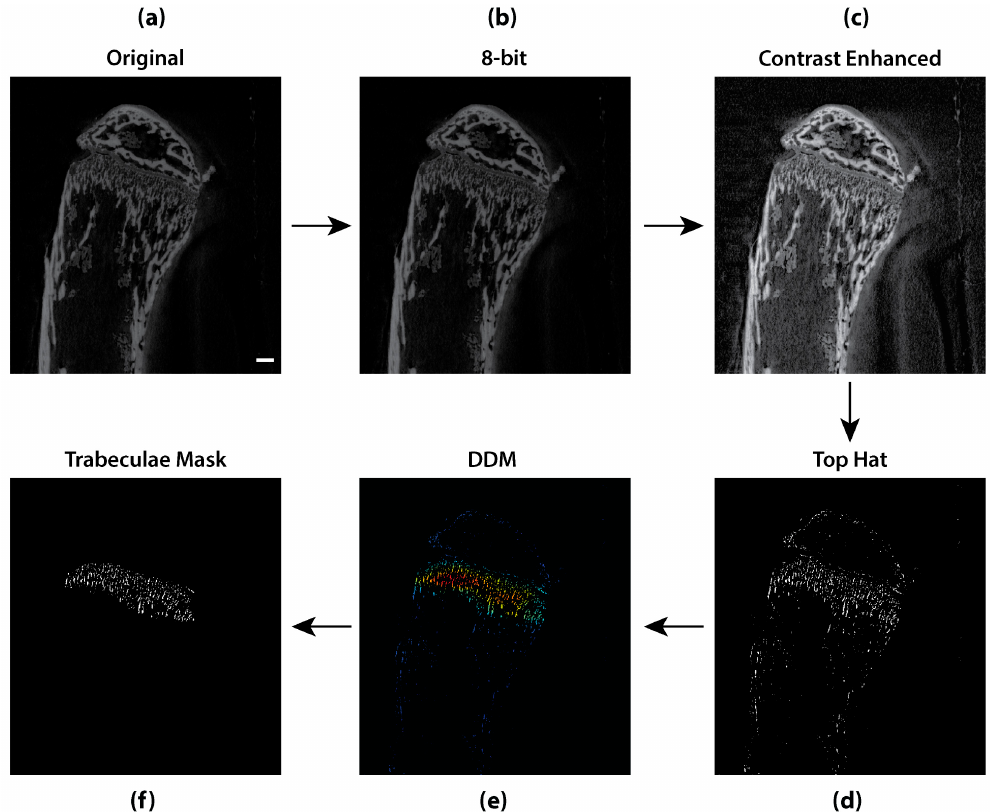
Figure 7. DDMs application to image segmentation. DDMs can applicate beyond distribution analysis in microscopy imaging: here, the segmentation of metaphyseal trabeculae in micro-CT (coronal) images of Mus musculus tibiae. The acquired image ( a ) is 8-bit converted for denoising purposes ( b ), contrast-enhanced by local adaptive histogram equalization ( c ) and top hat-filtered for the segmentation of local intensity peaks ( d ). This procedure well detects metaphyseal trabeculae, but also includes less dense signal from other bone structures. DDMs ( e ) permit to discriminate metaphyseal trabeculae as the denser local peaks in the image, and accordingly to segment them based on their local density ( f ). Scale bar: 200 µm.